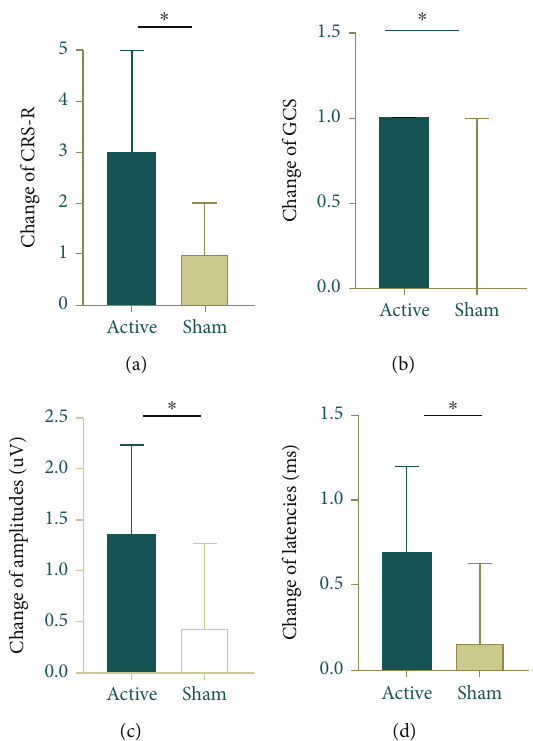
Figure 4: Changes in scores of clinical scales and electrophysiological parameters from baseline to postintervention for both groups. HF- rTMS produced a greater elevation of (a) CRS-R scores and (b) GCS scores in the active group than in the sham group; HF-rTMS produced (c) a substantial increase of N20-P25 amplitudes and (d) a substantial decrease of N20 latencies in the active group compared with the sham